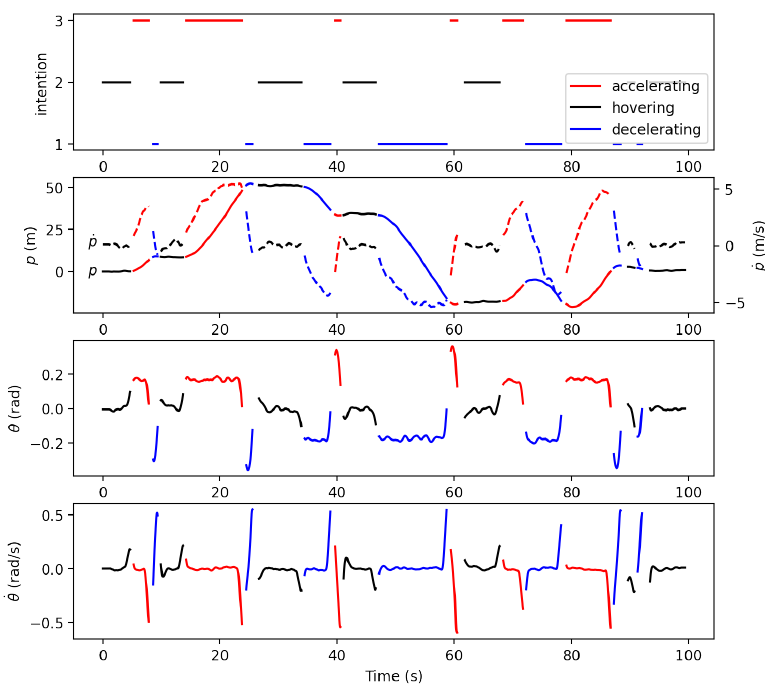
Figure 8. The inferred intention and the corresponding smoothed